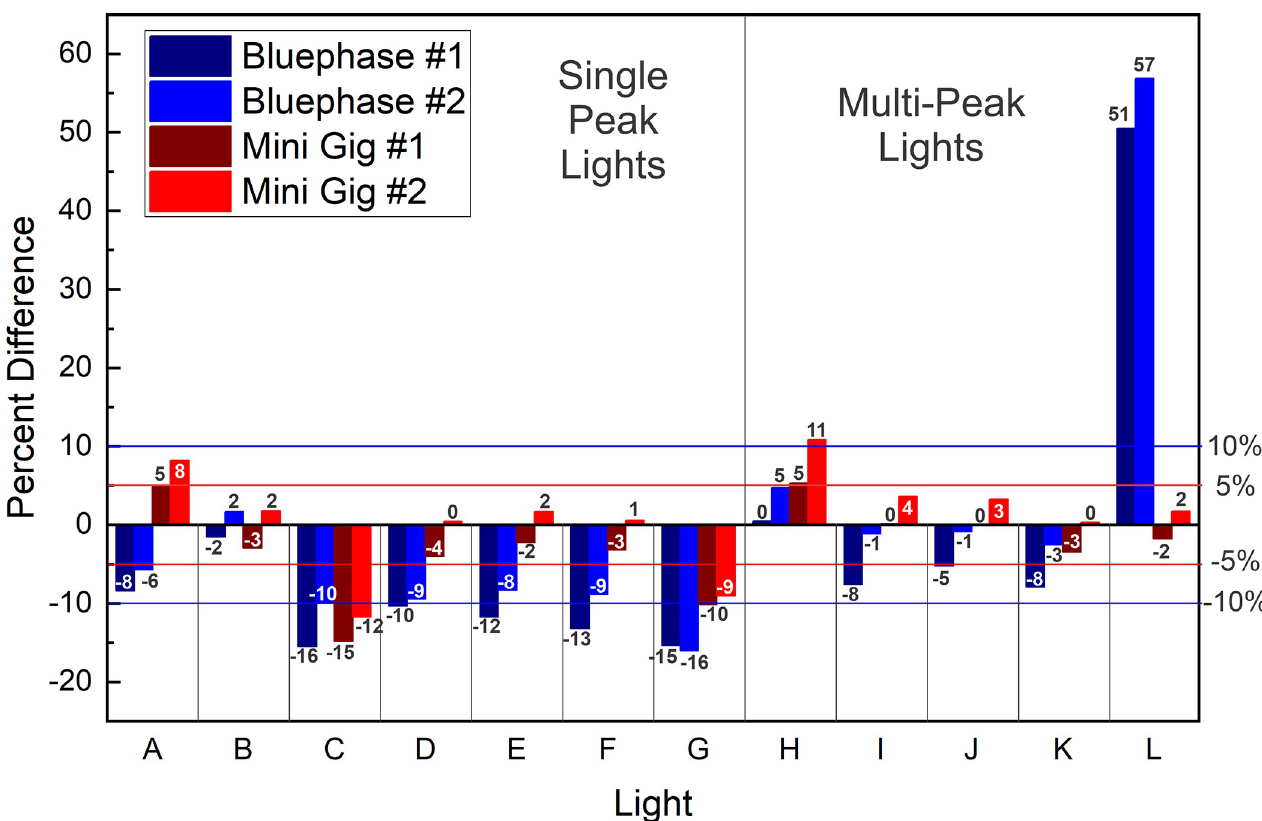
Fig 8. Percentage difference in the power values between radiometer units #1 and #2 of both radiometers compared to the ‘GS’ integrating sphere power values measured from unit #2 of each brand of LCU. Single Peak LCUs A) SmartLite Pro; B) DeepCure; C) Dental Spark; D) Denjoy; E) Woodpecker LED D; F) Woodpecker LED B; G) SDI Radii Plus; and Multi-peak LCUs H) Valo Grand; I) Bluephase G4; J) Valo; K) Bluephase Powercure; and L)